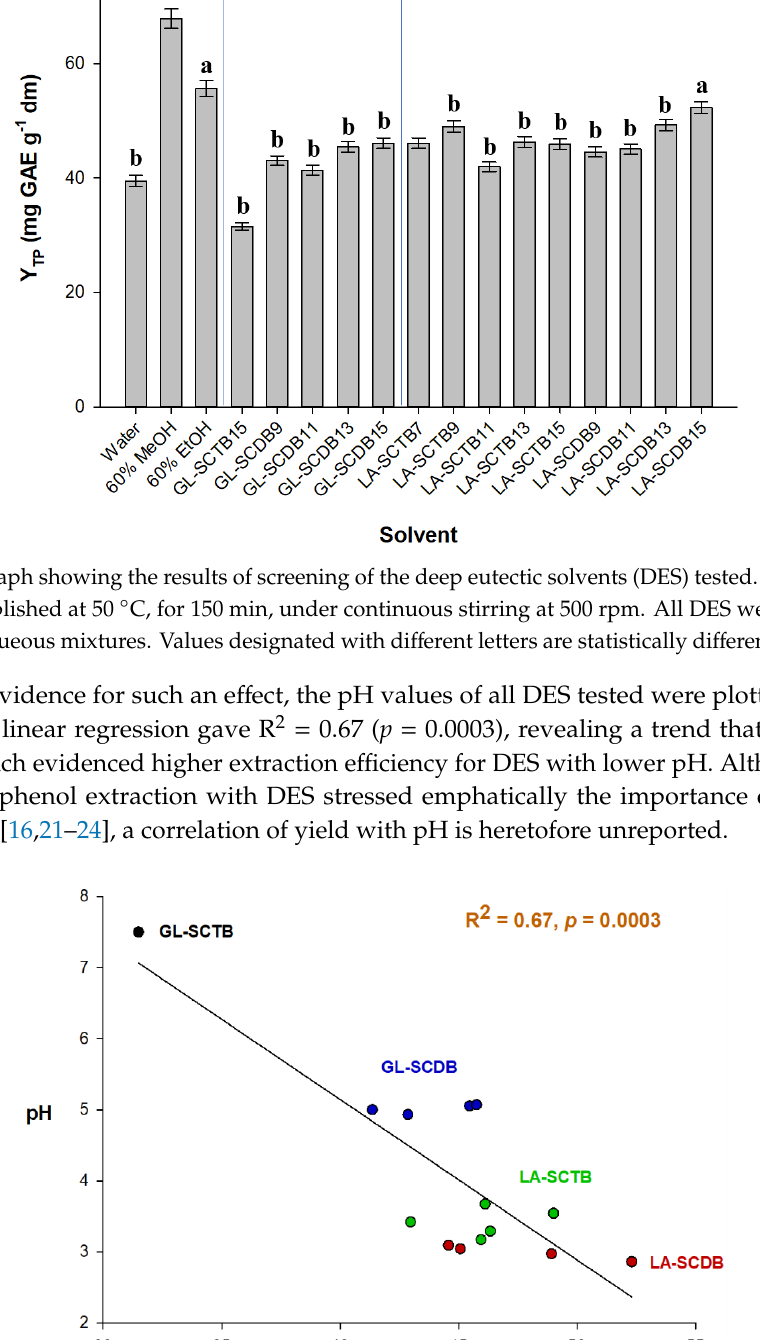
Figure 3. Linear regression between the pH of the DES tested and Y TP . All DES were tested as 70% ( w / v ) aqueous mixtures.